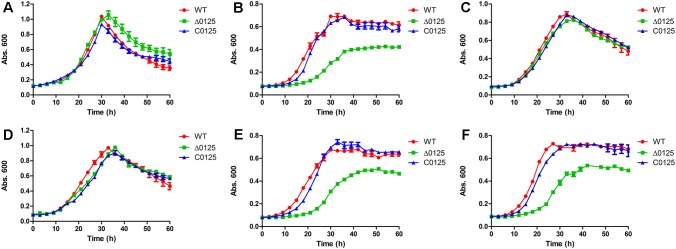
Growth curves of the wild type, the Δ0125 mutant and the C0125 in Stainer medium supplemented with 0.4% glucose (A), PY6 medium supplemented with 0.4% glucose (B), PY6 medium supplemented with 0.4% glucose plus 1 g/L KNO3
(C), PY6 medium supplemented with 0.4% glucose plus 1 g/L NaNO3
(D), PY6 medium supplemented with 0.4% glucose plus 1 g/L KCl (E), PY6 medium supplemented with 0.4% glucose plus 1 g/L NaCl (F). Values are the mean of three biological replicates. Error bars are the standard deviations from these replicates.